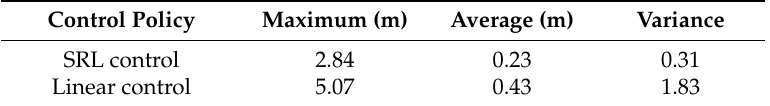
Table 3. Maximum, average, and variance of distance error, with the cycle of sinusoidal